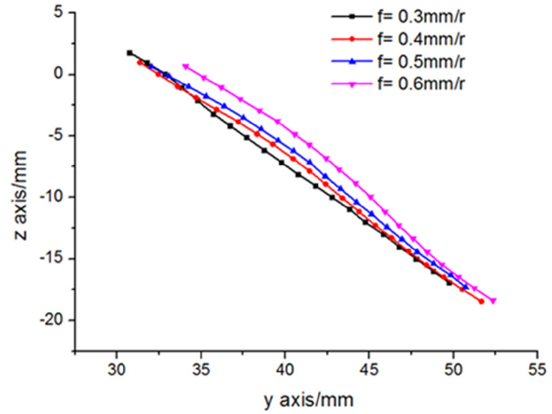
Figure 10. Effect of roller feed ratio on straightness.